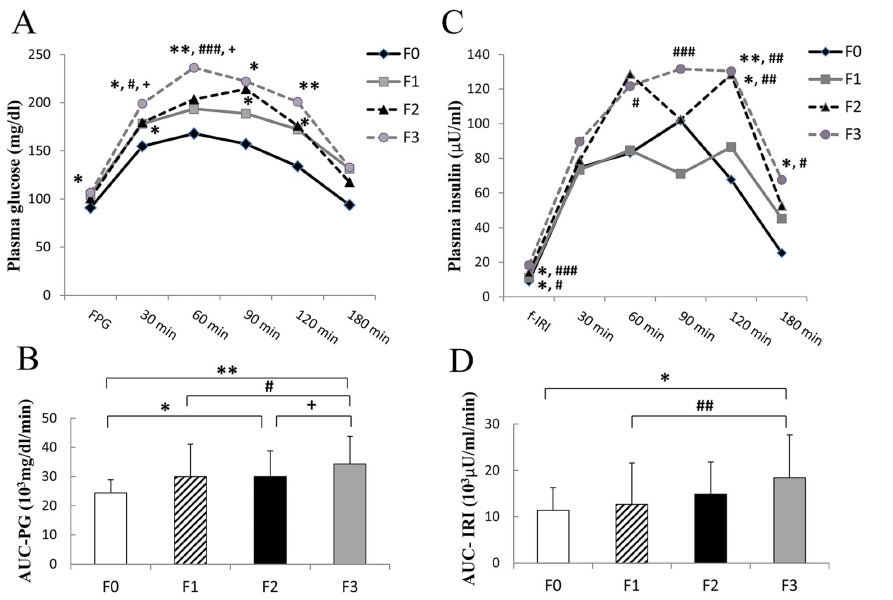
Figure 3. Patterns of glucose and insulin secretion in the 75gOGTT in relation to the progression of hepatic fibrosis. A) The glucose levels were significantly elevated in accordance with the progression of fibrosis (Versus F0: * P , 0.05, ** P , 0.01; Versus F1: # P , 0.05, ### P , 0.001; Versus F2: + P , 0.05). B) Area under the curve (AUC) of plasma glucose levels (AUC-PG) was remarkably larger in accordance with the progression of hepatic fibrosis (F0 versus F2, * P , 0.05; F0 versus F3, ** P , 0.01; F1 versus F3, # P , 0.05; F2 versus F3, + P , 0.05) C) Insulin secretion levels were remarkably higher in the patients with progression of hepatic fibrosis (Versus F0: * P , 0.05, ** P , 0.01; Versus F1: # P , 0.05, ## P , 0.01, ### P , 0.001). D) AUC of insulin secretion (AUC-IRI) was also significantly larger in accordance with the progression of hepatic fibrosis (F0 versus F3, * P , 0.05; F1 versus F3, ## P , 0.01). (Black diamond: F0: n=10. Gray square: F1: n=74. Black triangle: F2: n=48. Gray circle: F3: n=37; total, N=169).